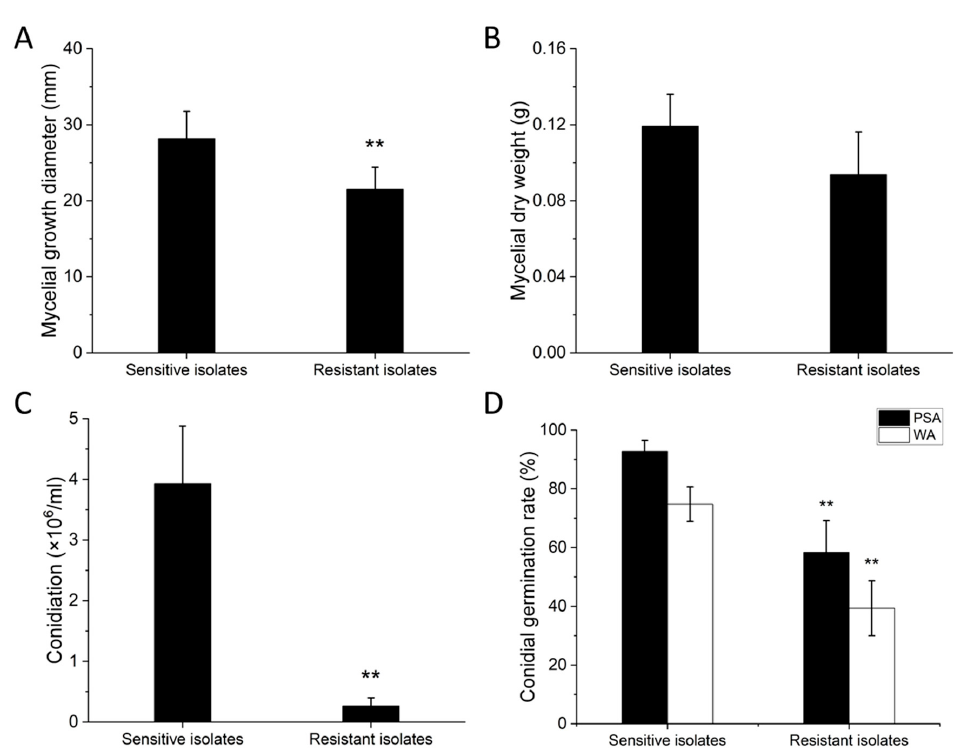
Figure 3. Biological characterization of carbendazim-sensitive and carbendazim-resistant